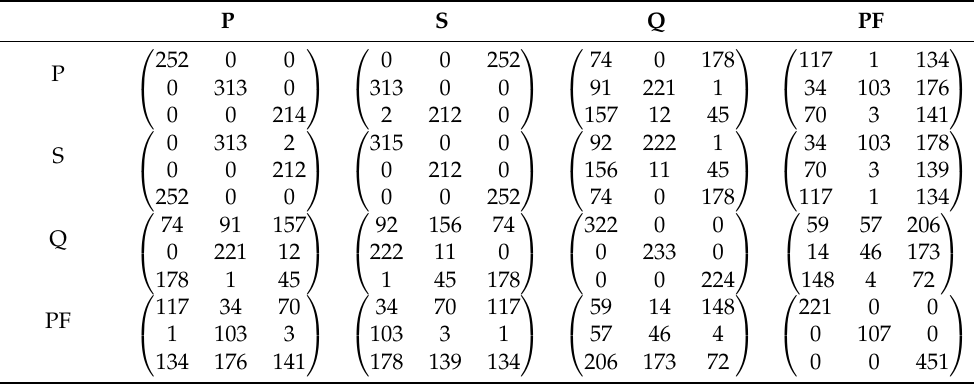
Table 3. Dispersion table in the coincidences. Scenario